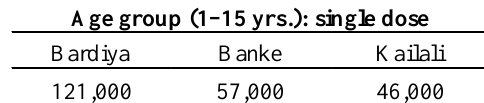
to 10 yrs are protected from JE during 2001/2002. Table II : Live attenuated SA-14-14-2 JE vaccine